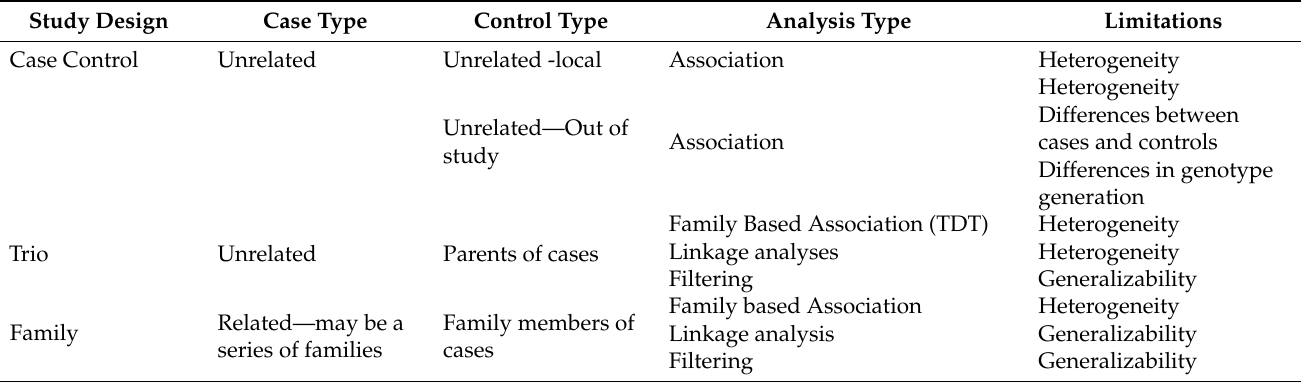
Table 3. Study designs, analysis types, and